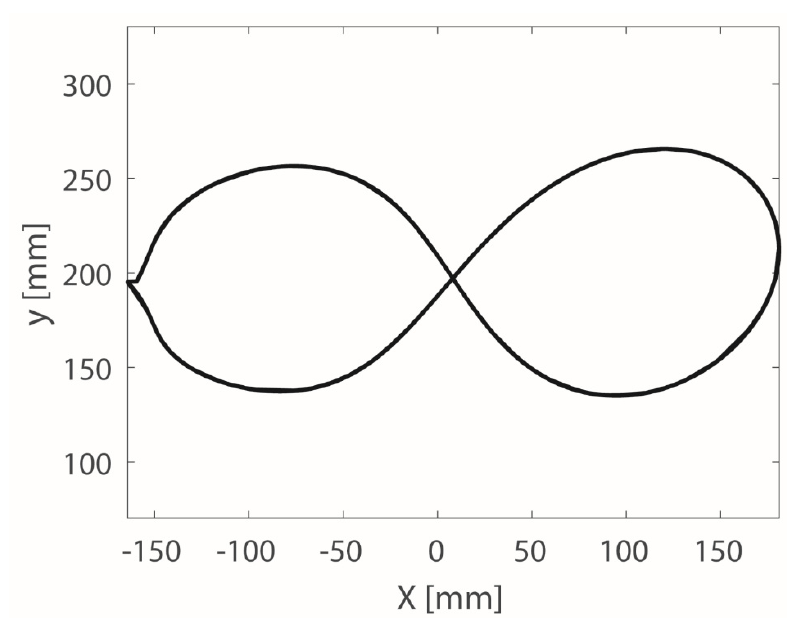
Figure 2. X and Y cartesian coordinates to trace the number eight.